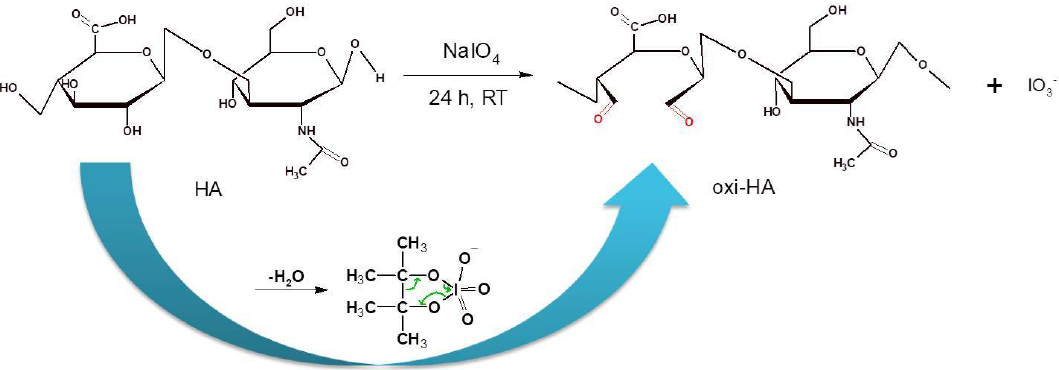
Figure 2. Partial oxidation of hyaluronic acid (HA) with sodium periodate (NaIO 4 ) to form oxidized hyaluronic acid (oxi-HA). In red, aldehyde groups, and in green, the bond breaks during oxidative cleavage.